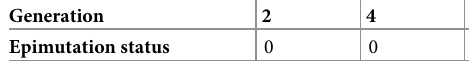
Table 6. Chromatin-based epimutation status for ugt-26 .